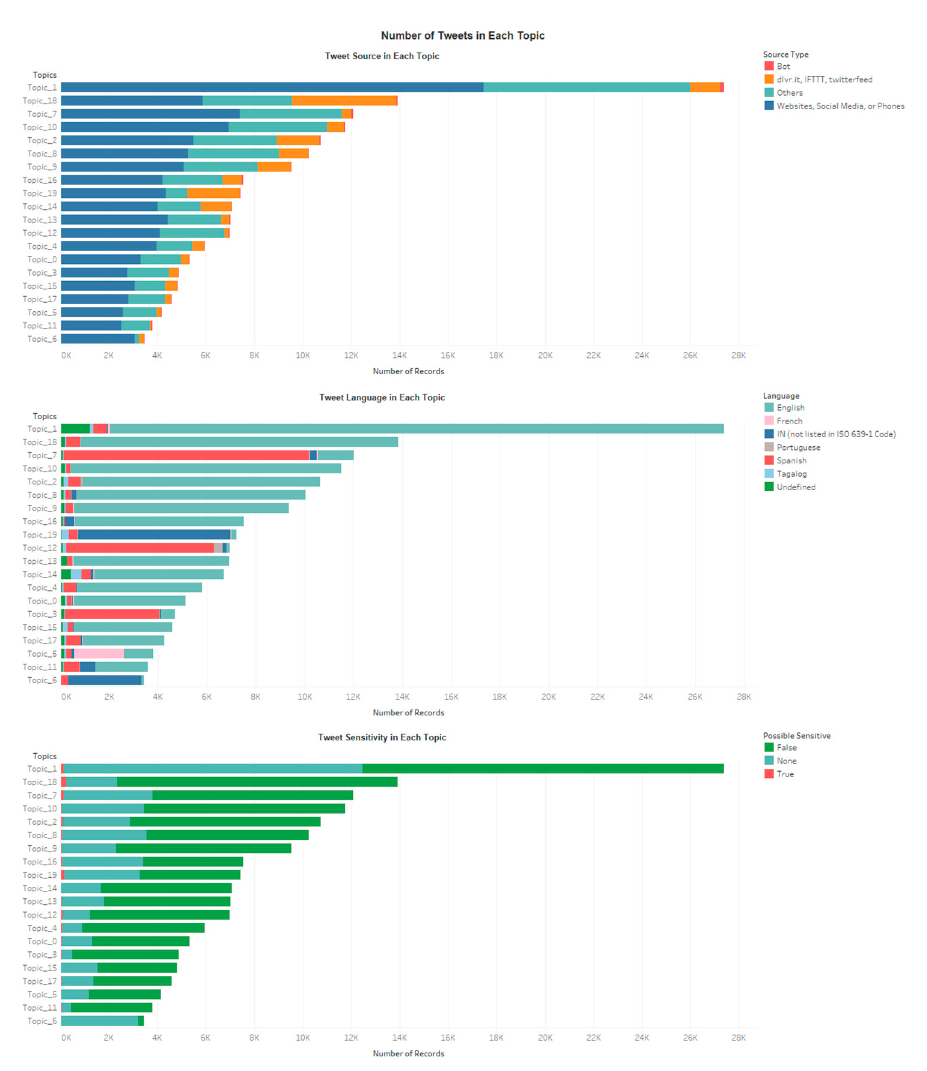
Figure 10. Tweet source, language and sensitivity.